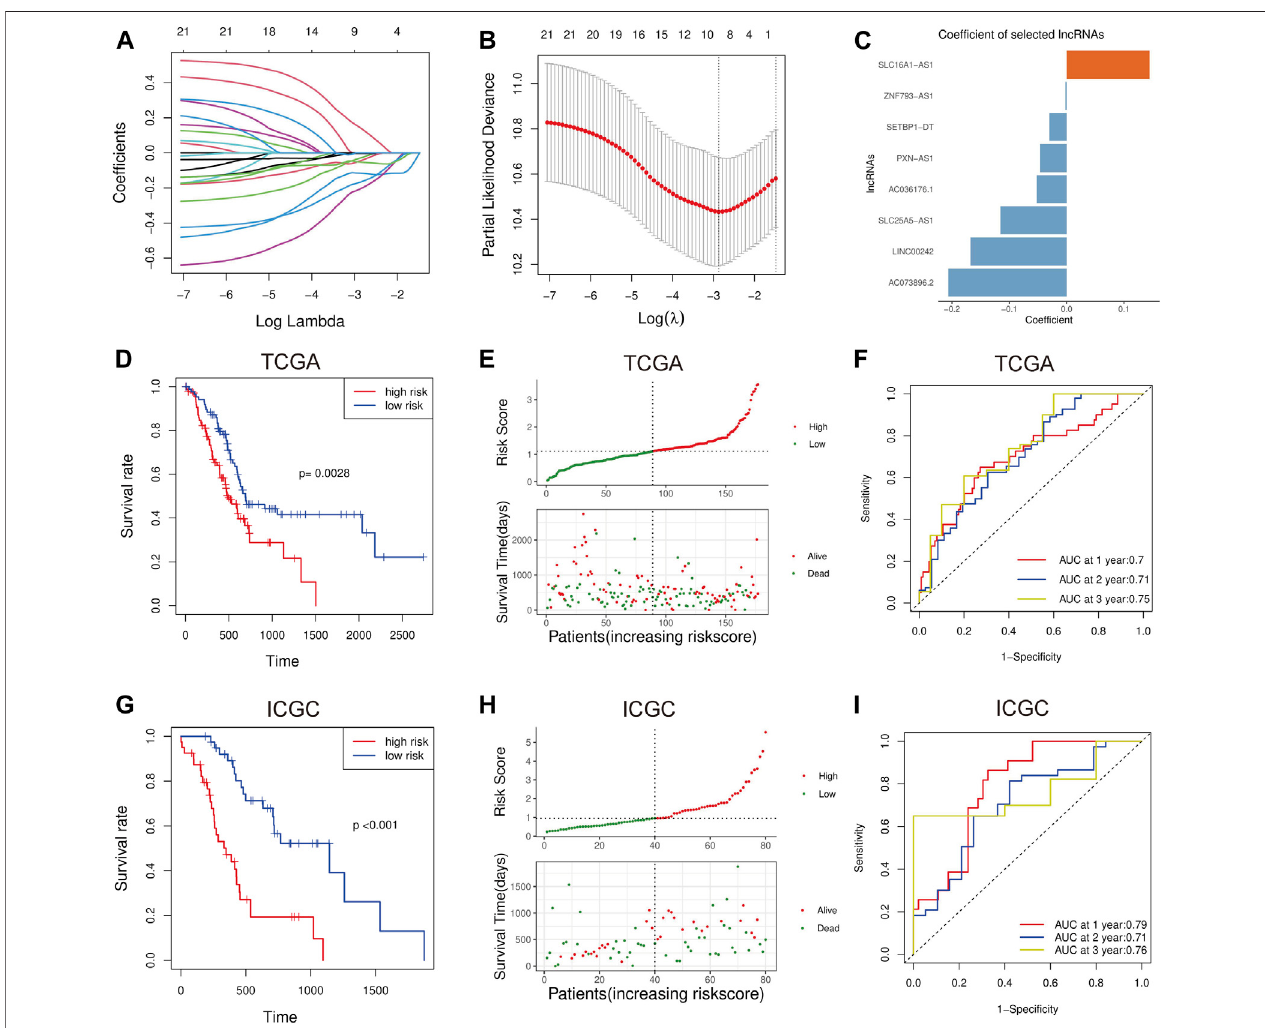
FIGURE 3 | The least absolute shrinkage and selection operator Cox (LASSO-Cox) analysis was implemented (A, B) , and the coef fi cients were calculated by the 10-fold cross-validation based on minimum criteria (C) . Kaplan-Meier analysis suggests the OS in the high-risk and low-risk groups in the TCGA cohort (D) . Distribution ofriskscoresand survivalstatus ofPCpatients inthe TCGA cohort (E) .Receiver operating characteristic (ROC) curveanalysisforFe-LPM inthe TCGA cohort (F) . Inthe ICGC validationcohort, theresults oftheKaplan-Meier analysis wereconsistent withthose inthe TCGA cohort (G) . Distribution ofrisk scoresand survival status of PC patients in the ICGC cohort (H) . Receiver operating characteristic (ROC) curve analysis for Fe-LPM in the ICGC validation cohort (I) .